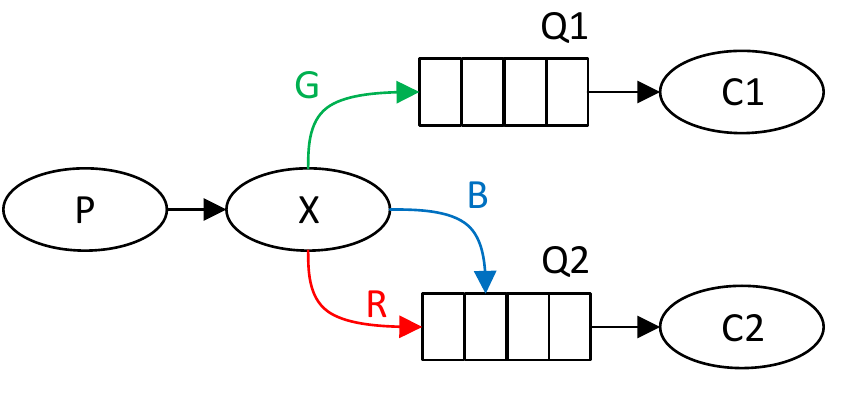
Figure 1. Simplified RabbitMQ